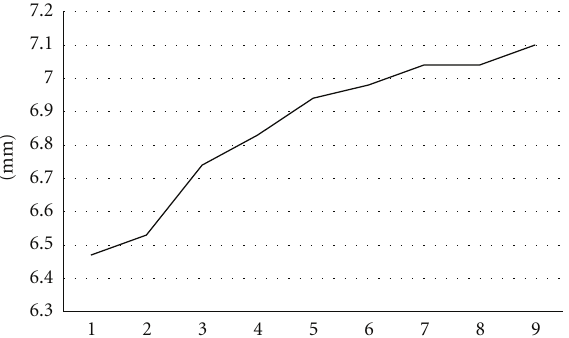
Figure 4: Size order of midth modiolar lateral wall distance of used temporal bones.